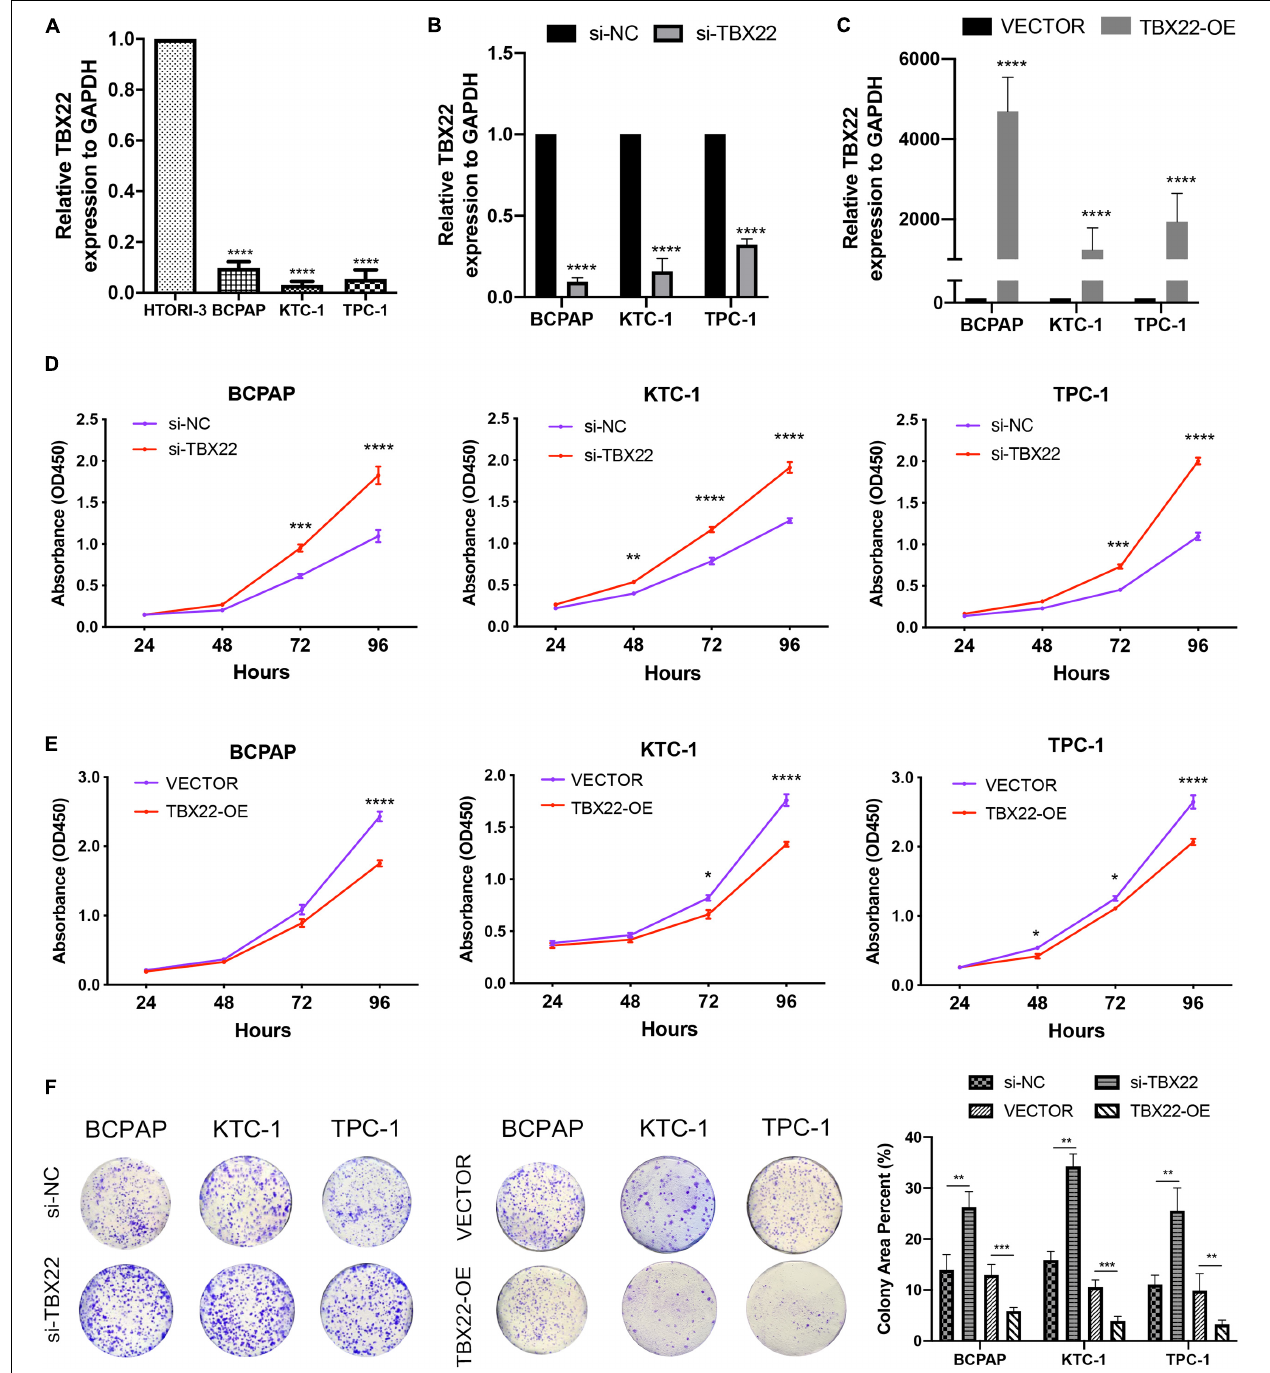
FIGURE 9 | TBX22 was downregulated in PTC cell lines and attenuated the capability of proliferation. (A) Relative TBX22 mRNA expression levels were significantly lower in thyroid cancer cell lines (BCPAP, TPC-1, and KTC-1) compared with the normal thyroid epithelial cell line HTori-3. (B) Transcriptional level of TBX22 in si-NC and si-TBX22 transfected PTC cells via qRT-PCR. (C) Transcriptional level of TBX22 in VECTOR and TBX22-OE group via qRT-PCR. (D,E) CCK-8 assays determined the cell viability of (D) loss-of-TBX22 and (E) gain-of-TBX22 PTC cells. (F) Colony formation assays were used to determine the cell colony formation ability of loss-of-TBX22 and gain-of-TBX22 PTC cells. Student’s t -test was used in comparison with the si-NC or VECTOR groups. * p < 0.05, ** p < 0.01, *** p < 0.001, **** p < 0.0001 in data analysis, and all assays were repeated at least three times.